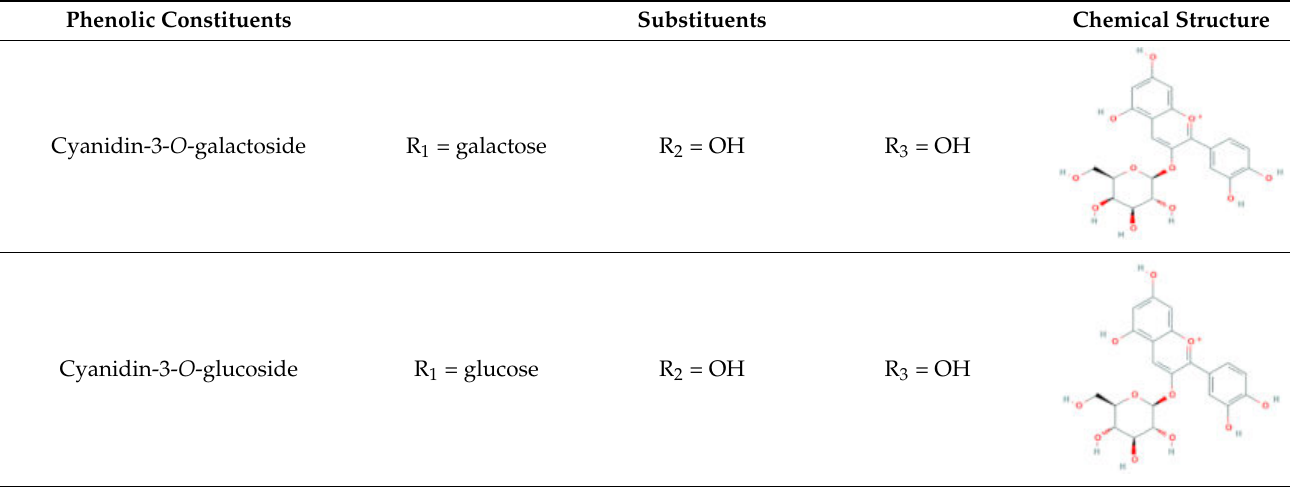
Table 5. Chemical structures of anthocyanins